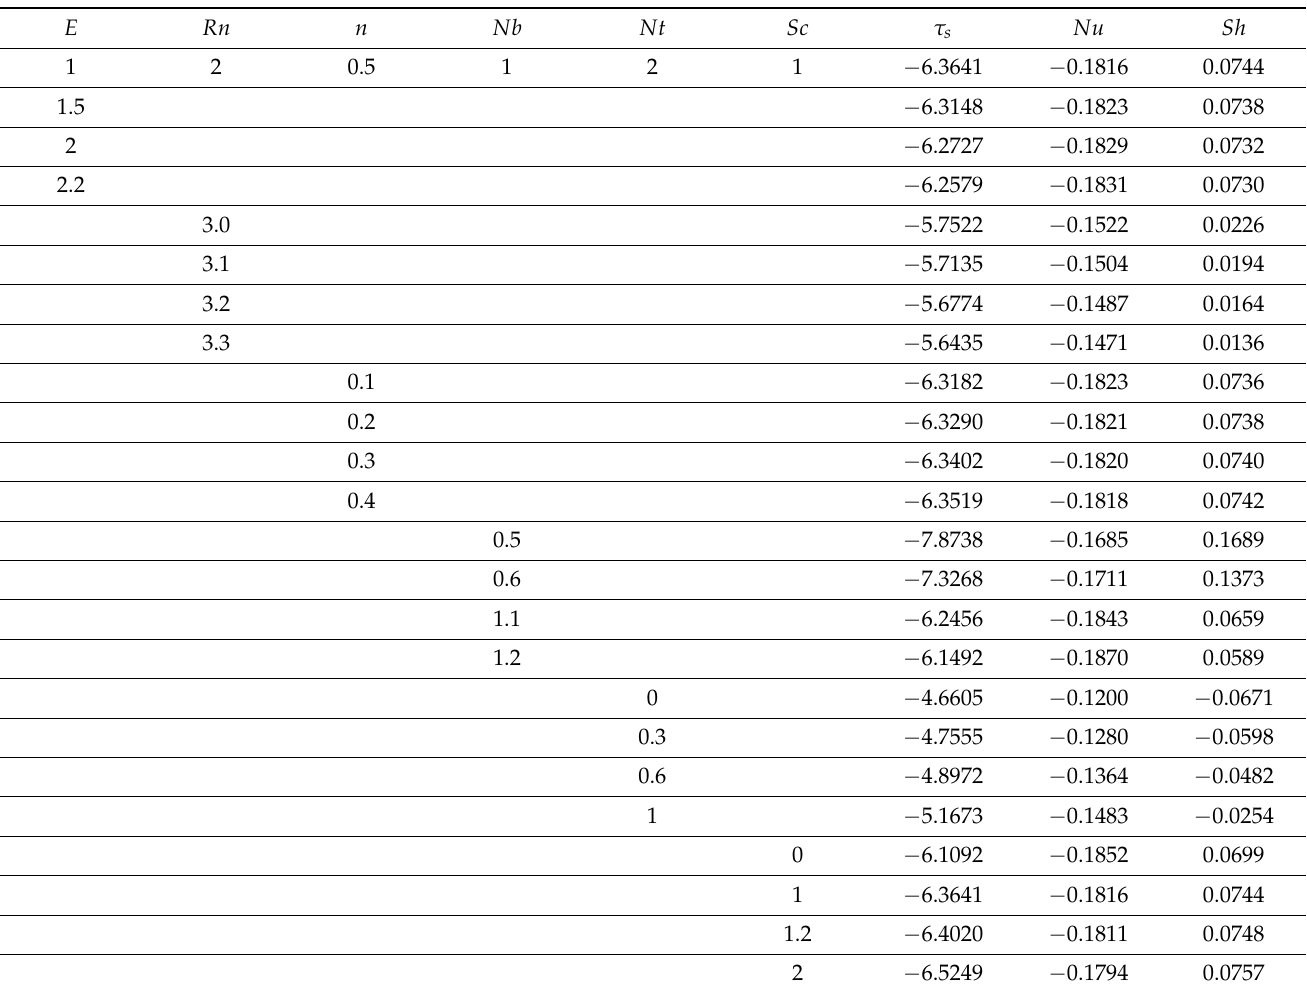
Table 2. Variations in Nusselt number, shear stress, and Sherwood number with various fluid parameters.